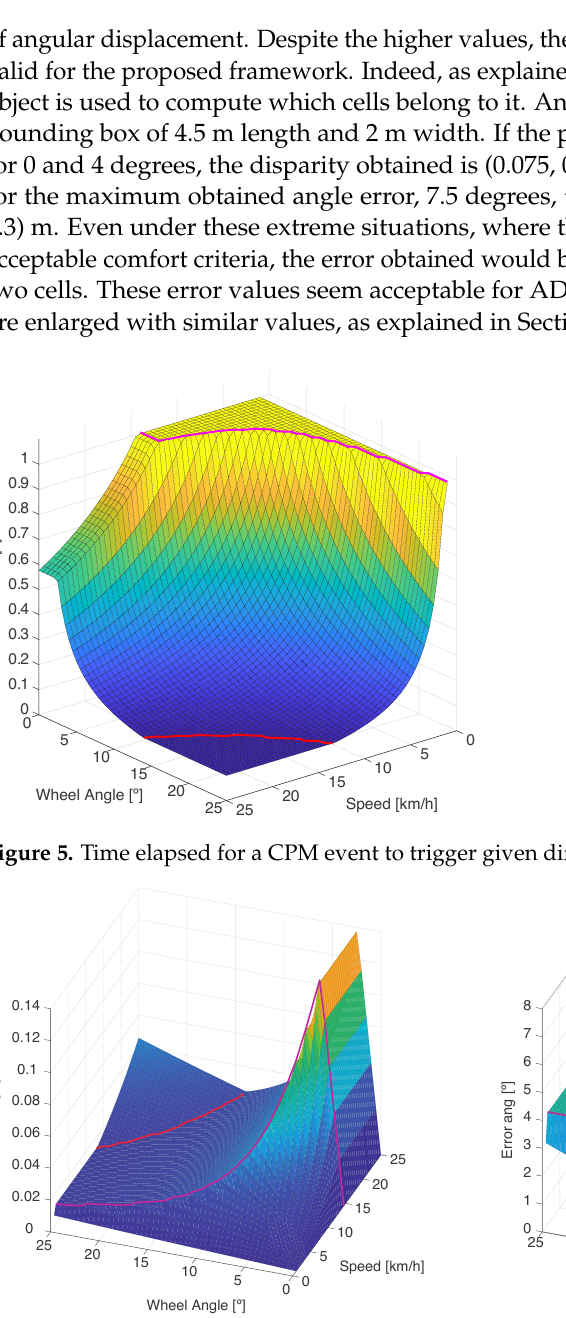
Figure 6. Maximum error achieved when predicting the state until next